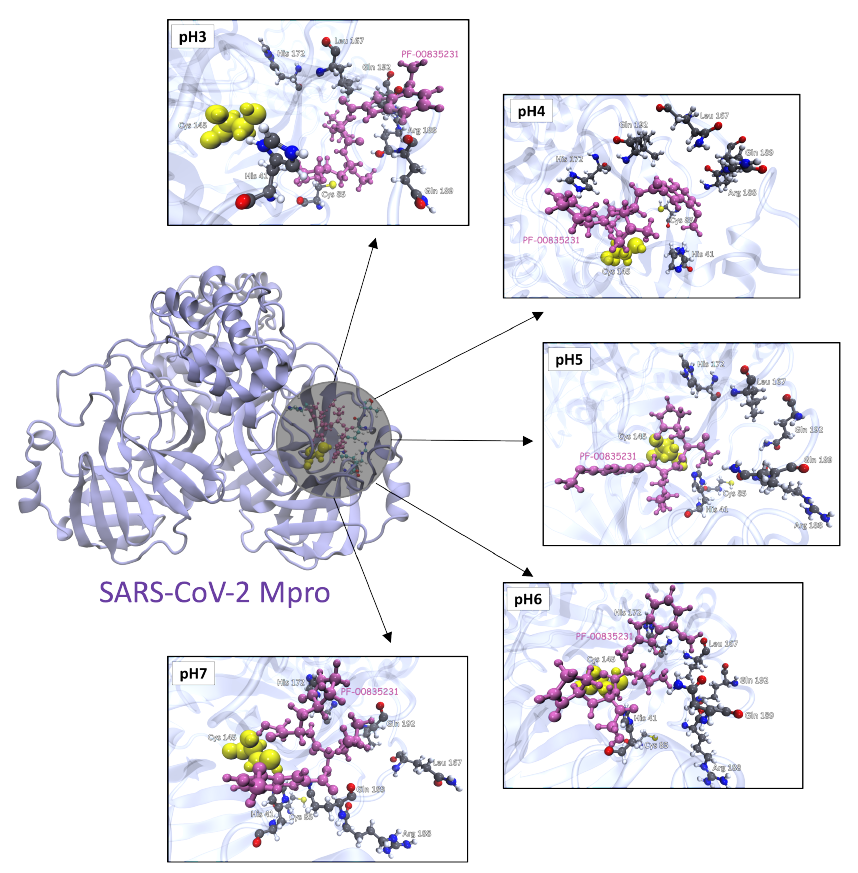
Figure 11. Docking snapshot of the best binding affinity at different pHs between PF-0085231 and SARS-CoV-2 Mpro. The Cys145 is highlighted in yellow and the PF-00835231 drug is highlighted in pink. The ligand is located close to the SARS-CoV-2 Mpro active site at different conditions of